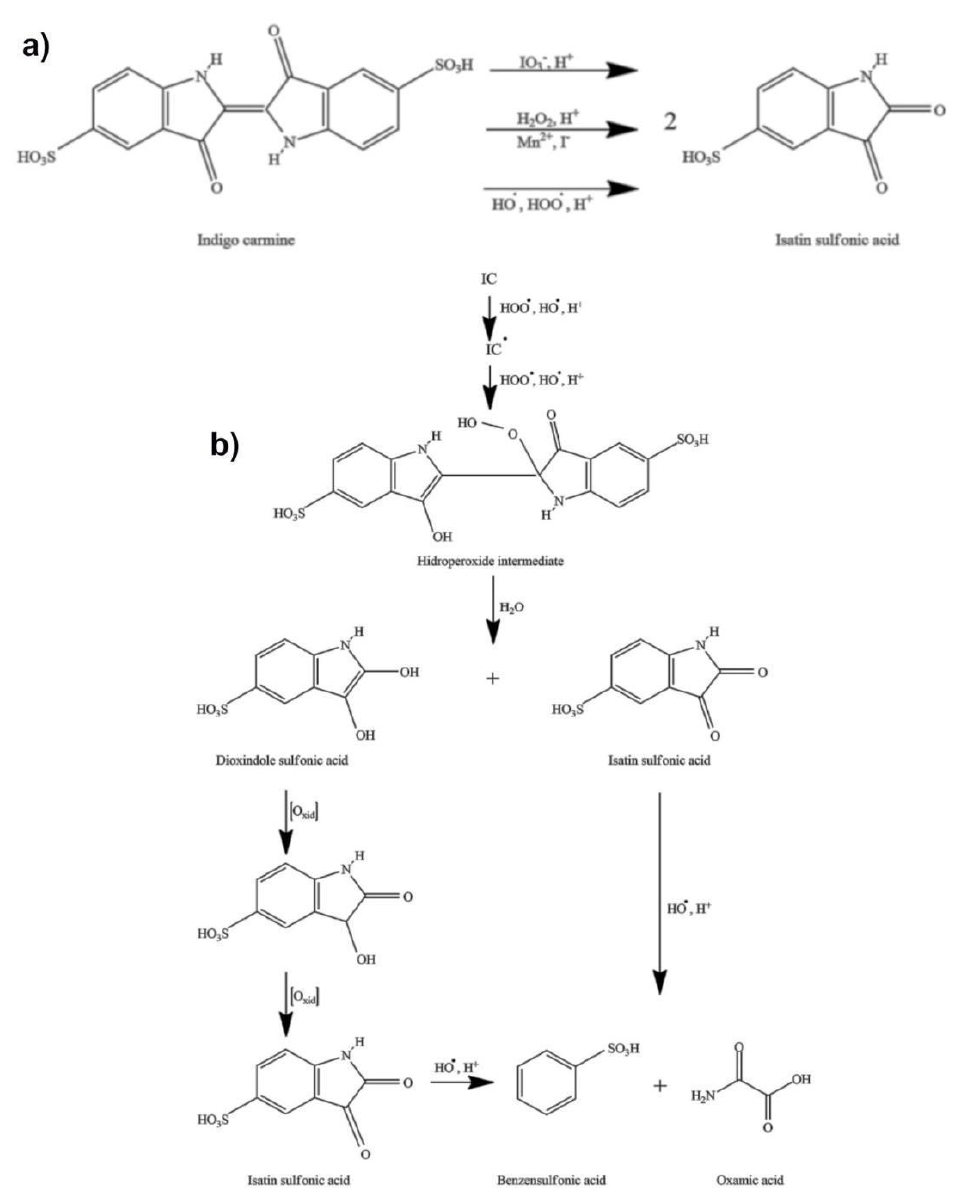
Figure 5. ( a ) the possible reaction pathways of indigo carmine oxidation in a Briggs–Rauscher oscillatory reaction ( b ) the mechanism of indigo carmine (and its derivative) action with HOO• /HO• radicals. in the Briggs–Rauscher (BR) reaction (for more details see references [65–68]). The multiple oxidation reactions account for the high sensitivity of the BR towards indigo carmine. Any indigo carmine concentration that disturbs the BR oscillogram is less than 10 − 5 M. Further, a concentration of indigo carmine ≤ 10 − 6 M may cease the oscillatory behavior